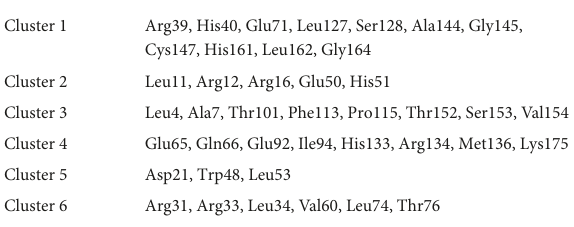
TABLE 2 Six clusters formed between 21 3C pro -inhibiting candidates and 5C1U with involved interacting residues at each cluster. Binding